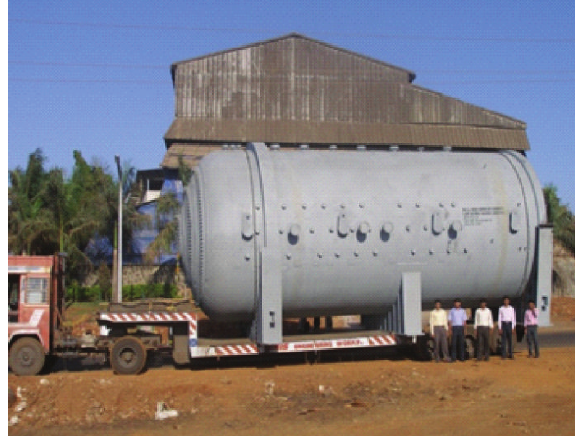
Figure 10: Transportation of the autoclave